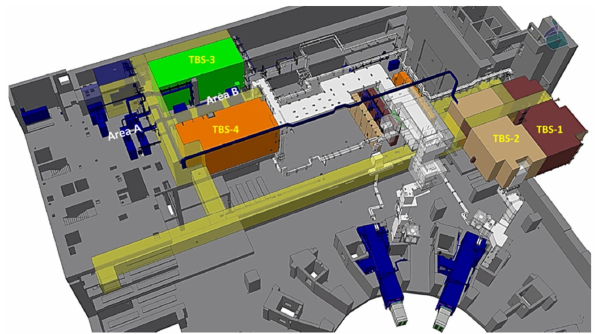
Figure 10. General view of the distribution of the main elements of the 4 TBS within the tokamak and tritium building. Reprinted with permission from Ref. [59]. Credit c (cid:13) Elsevier,